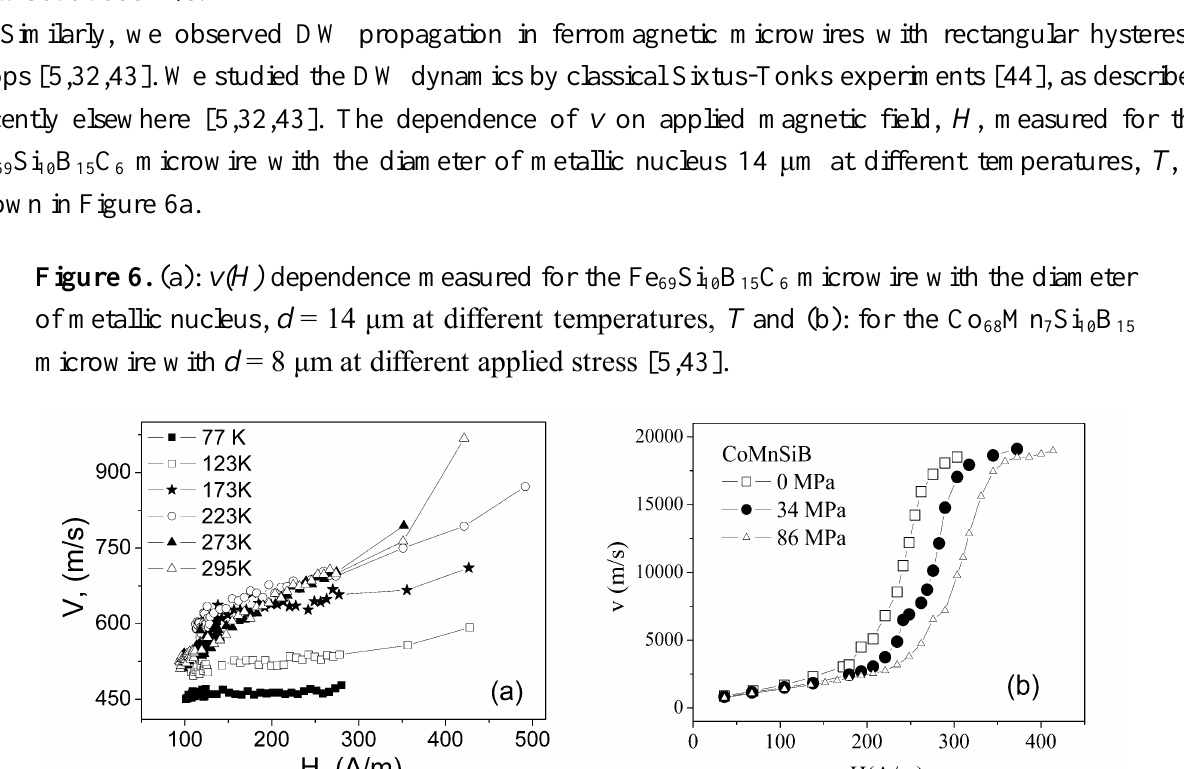
Si B C microwire with the diameter 69 10 15 6